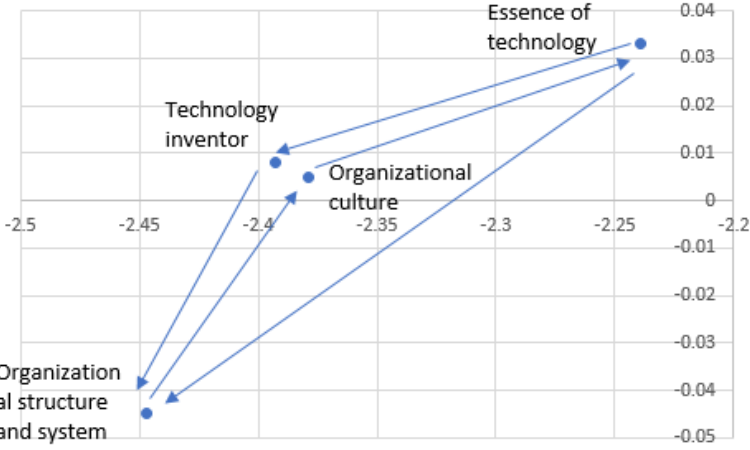
Figure 2. Causal diagram of main aspects.